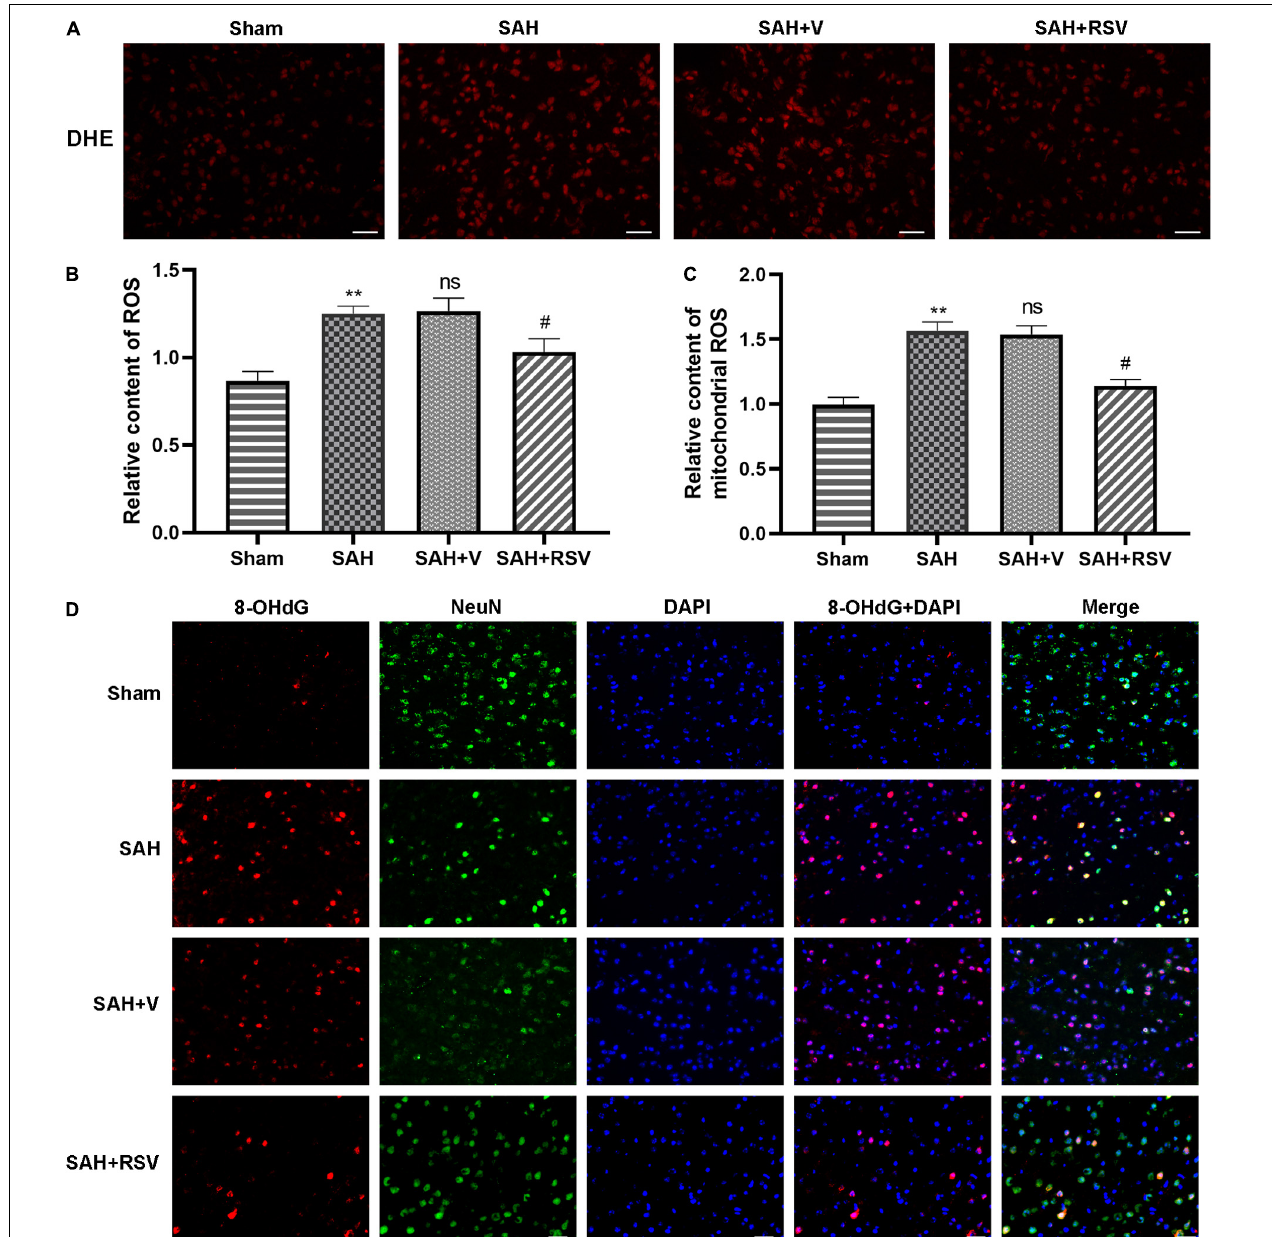
FIGURE 4 | Effect of RSV on ROS scavenging was evaluated 24 h following SAH. (A,B) RSV suppressed the production of intercellular ROS detected by DHE staining. RSV treatment reduced the total ROS content compared with the vehicle group. n = 6 per group. (C) Mitochondrial ROS was evaluated by MitoSOX staining, and production of mitochondrial ROS was markedly decreased by RSV treatment. n = 6 per group. (D) Representative images of 8-OHdG by immunofluorescence assay indicated that RSV abrogated the formation of 8-OHdG. n = 6 per group. Data were represented as mean ± SEM ( n = 6). ** p < 0.01 vs. sham group; ns p > 0.05 vs. group with SAH; # p < 0.05 vs. vehicle-treated